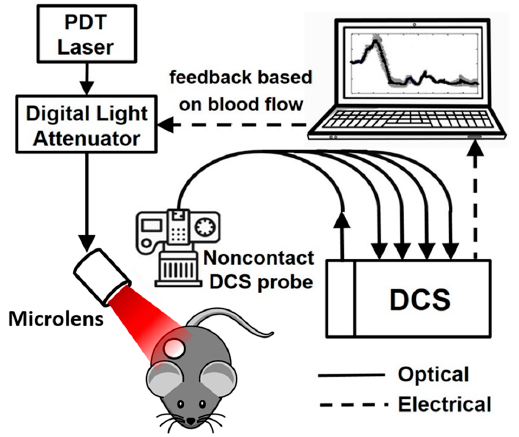
Figure 1. Schematic of blood-flow-informed photodynamic therapy (BFI-PDT) light delivery system.